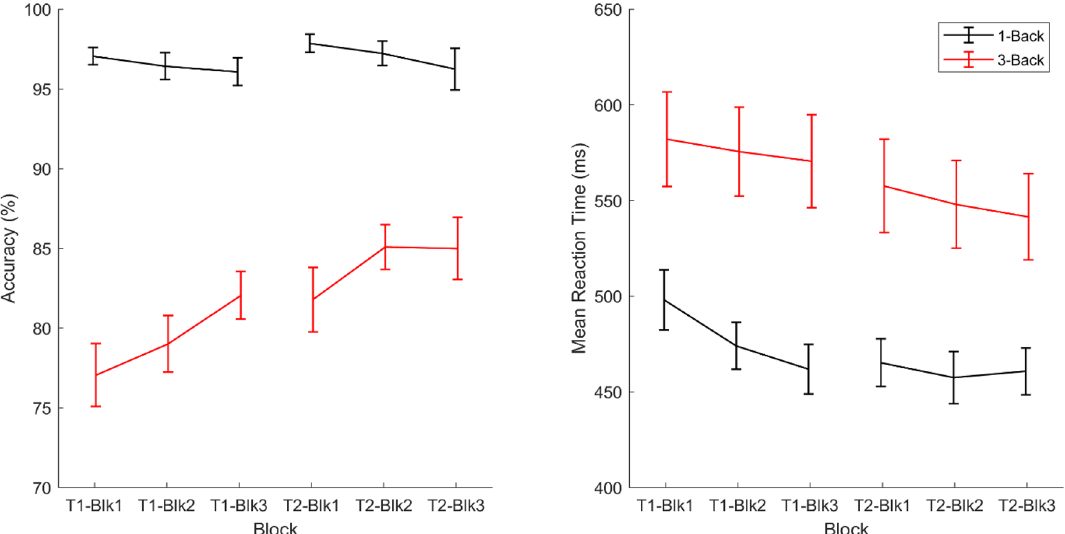
Figure 3. Time courses of accuracy and mean reaction time. Note Blk = Block; T1 = Time 1; T2 = Time 2. Error bars indicate 1 standard error ± the